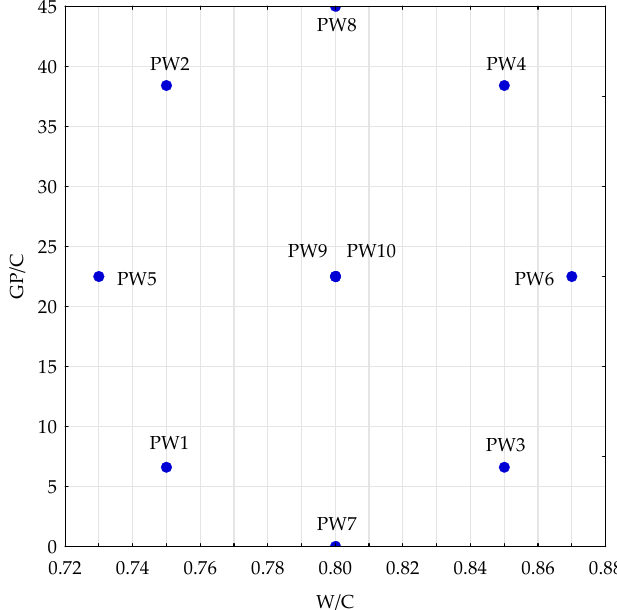
Figure 1. Applied central composite design. Table 1. List of coded and actual